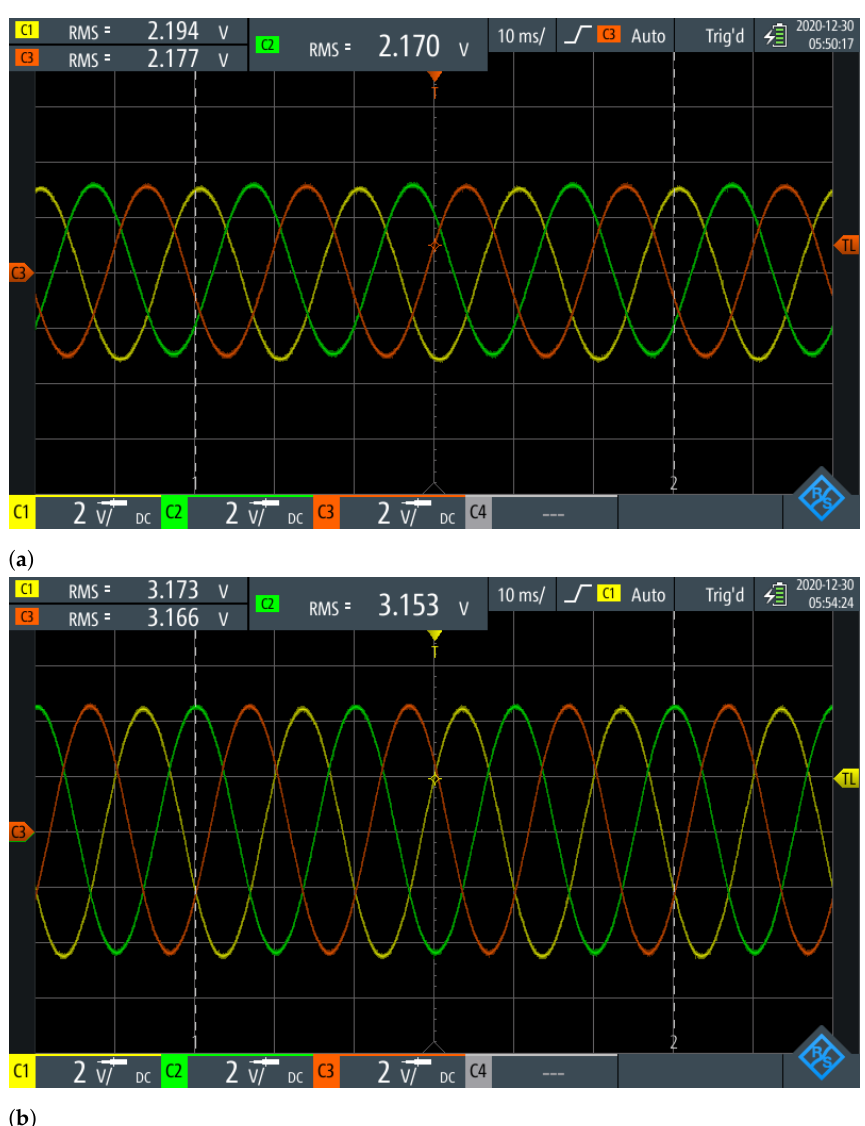
Figure 9. Real-time simulation results on DSO with respect to time (s) ( a ) V abc o (scaled down by 100); and ( b ) I abc o (scaled down by 10